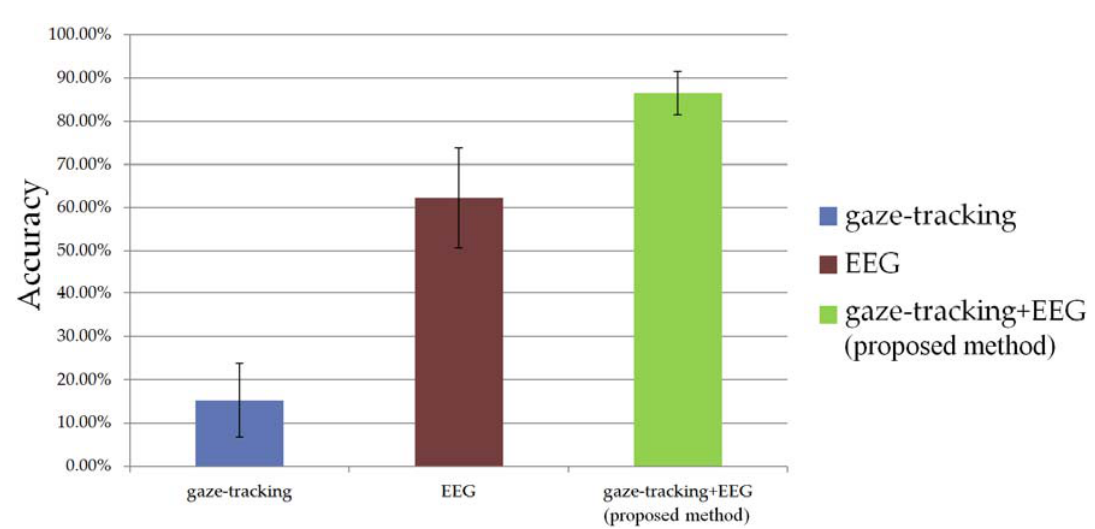
Figure 8. Comparisons of the average accuracies with three